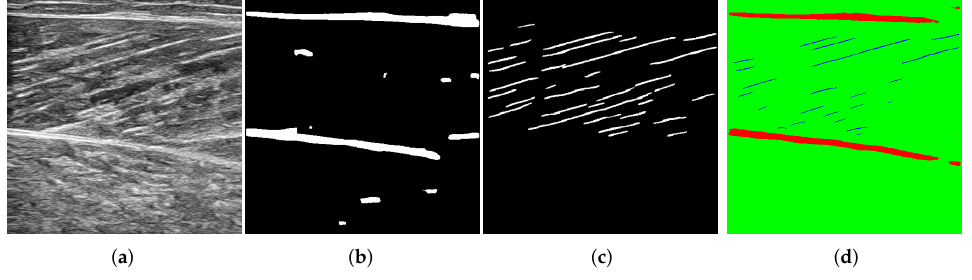
Figure 10. The segmentation results of the DL method and the proposed method. ( a ) The original image. ( b ) The segmentation result of aponeuroses by the DL model. ( c ) The segmentation result of fascicles by the DL model. ( d ) The segmentation result by the proposed